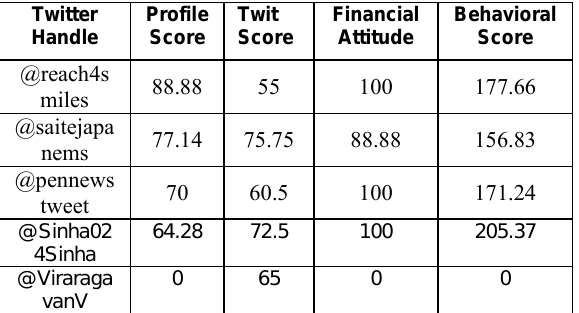
Table 8. Behavioral Score